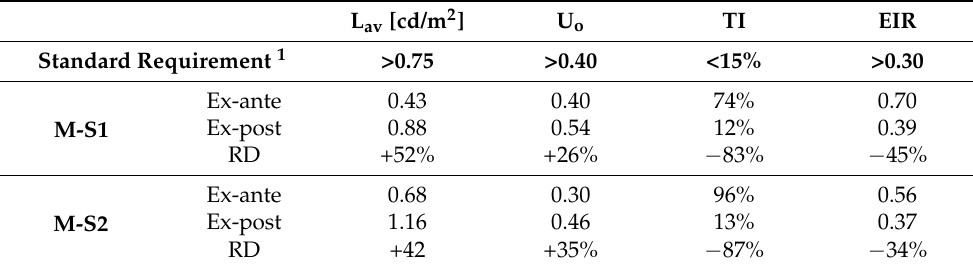
Table 5. Lighting performances of the ex-ante and ex-post installations for the representative drive- way